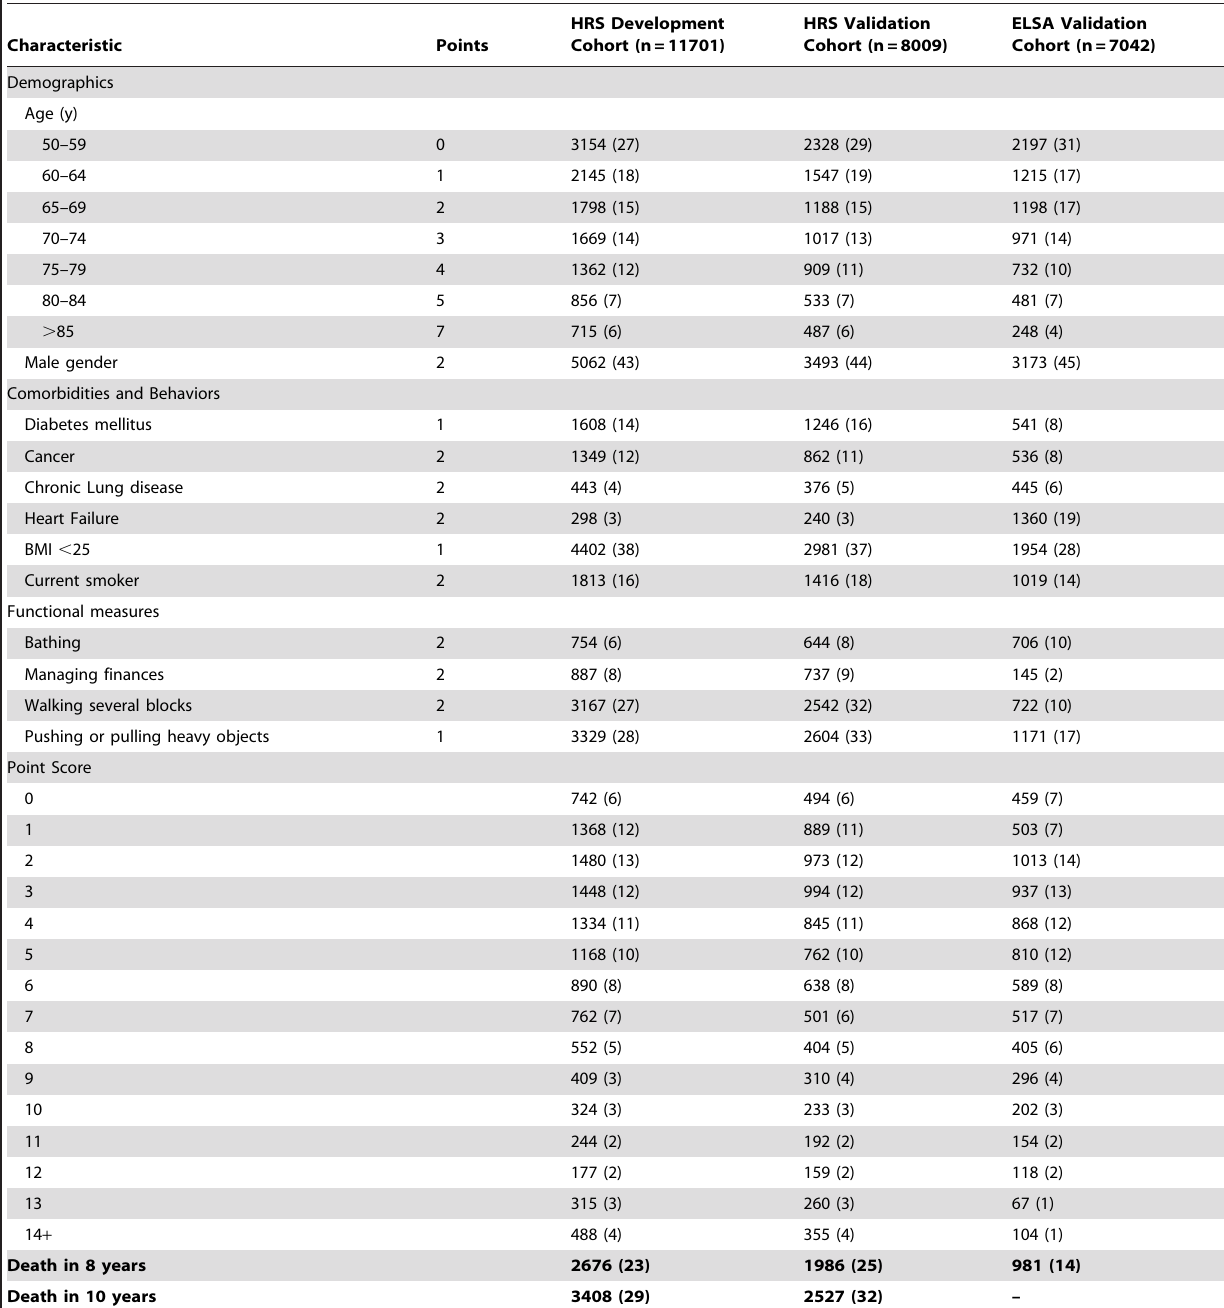
Table 1. Characteristics of